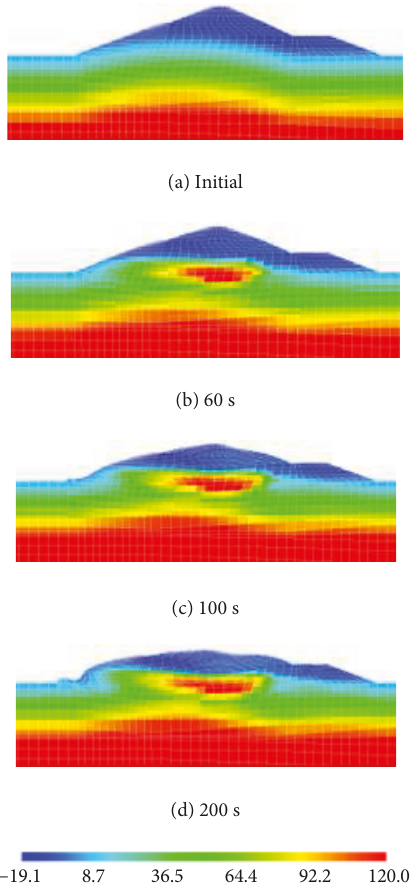
Figure 23: Distribution of pore water pressure (unit: kPa).